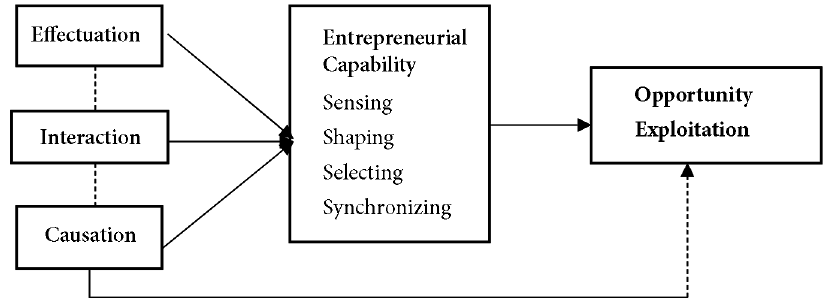
Figure 1. Research